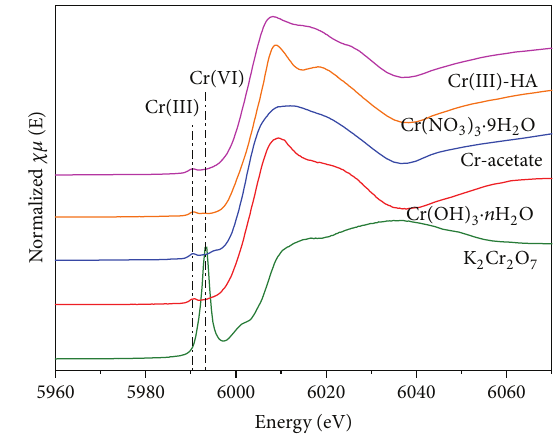
Figure 4: Normalized Cr K-edge XANES spectra for the Cr reference materials of K 2 Cr 2 O 7 , Cr(OH) 3 ⋅ n H 2 O, Cr-acetate, Cr(NO 3 ) 3 ⋅ 9H 2 O, and